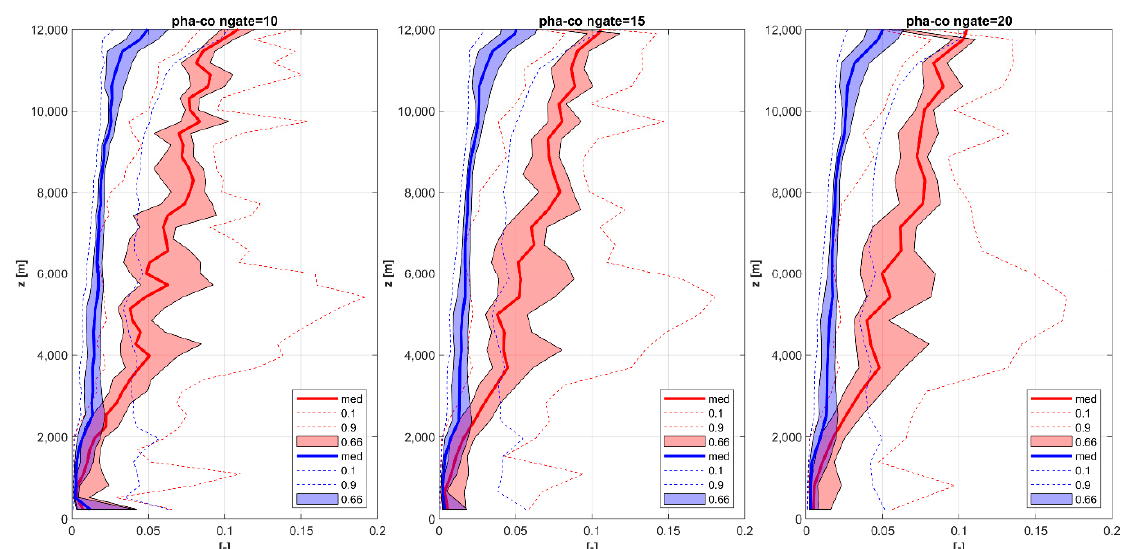
Figure 7. Distribution of pha in the co-channel for (red) “near(0.75 km)” and (blue) “far” data depending on layer thickness (from the left to the right: ngate = 10, 15 and 20). Each panel shows median values (“med”), the area between 33rd and 66th percentiles (“0.66”) and the dashed lines represent 10th and 90th percentiles (“0.1” and “0.9,” respectively). The y-axis displays the height above the radar site (z [km]). The pha is expressed in arctan of the phase degree.